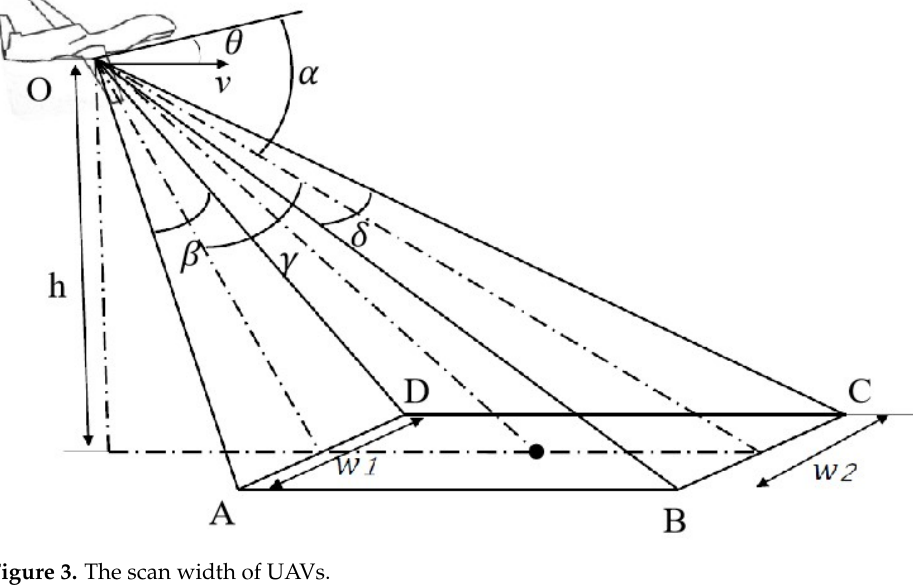
Figure 3. The scan width of UAVs.